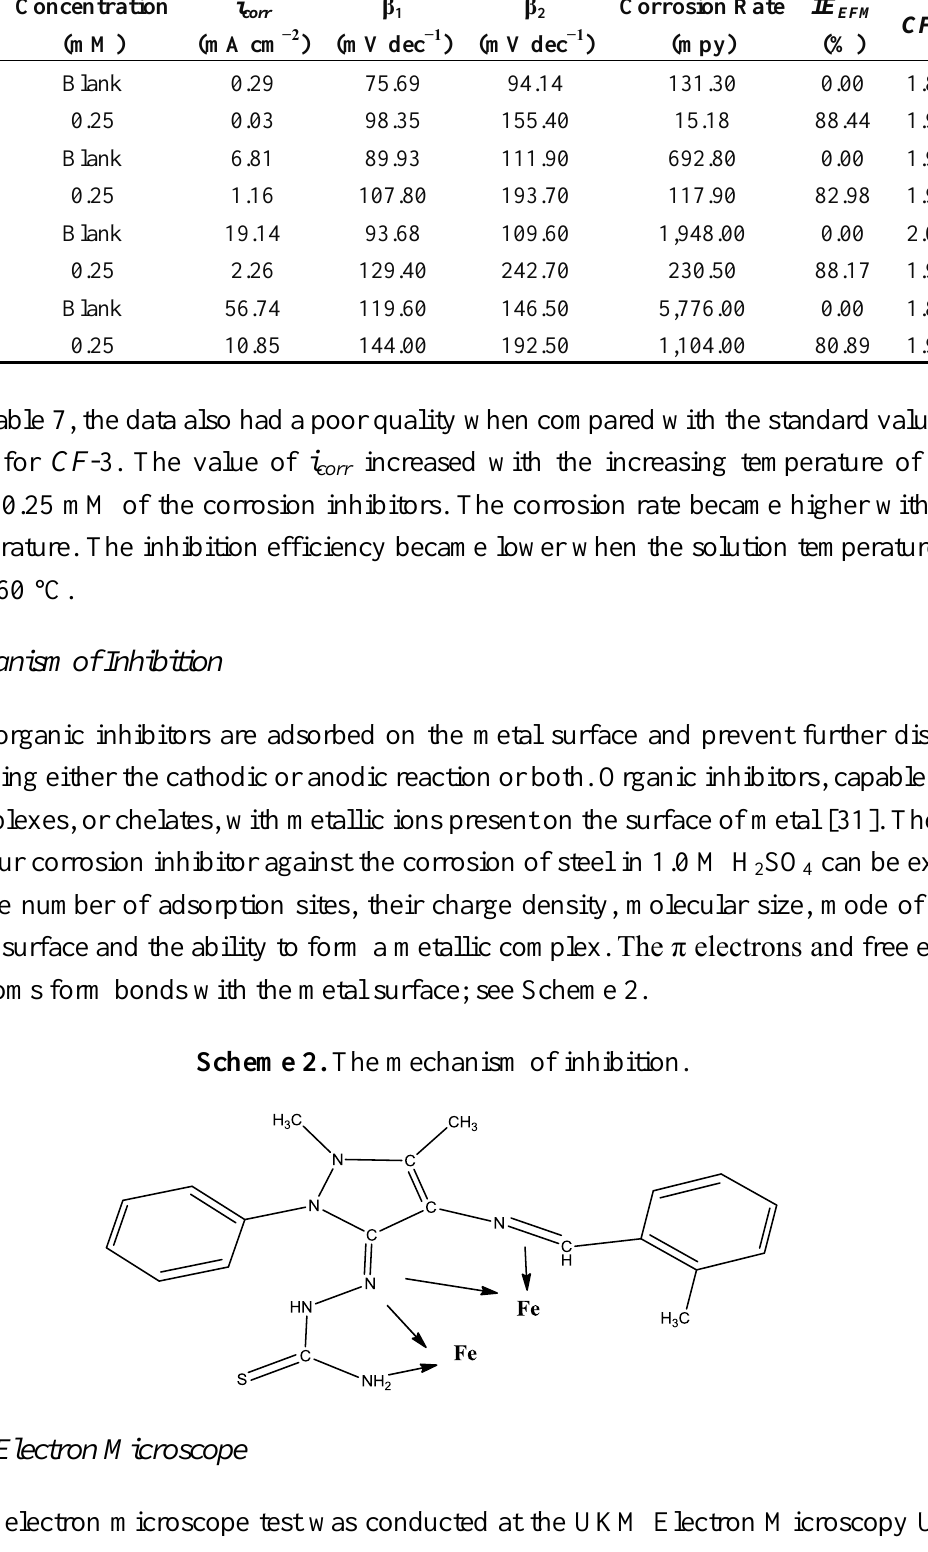
SO with 0.25 mM of 2 4